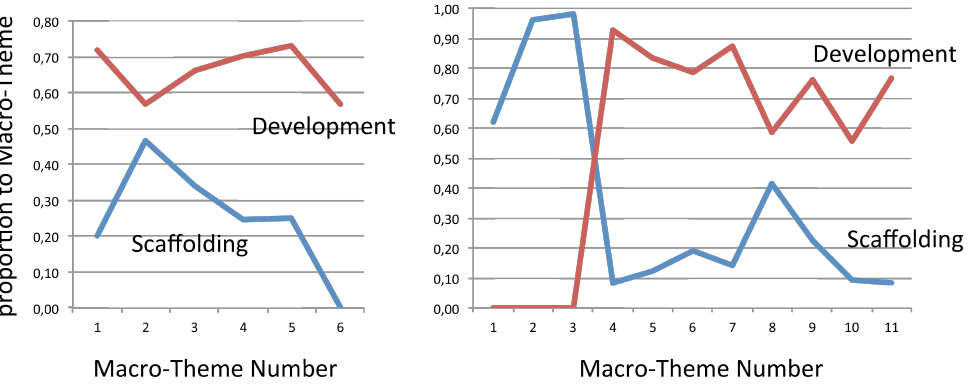
Figure 4. Comparison of discourse construction strategy profiles (proportions with respect to visual macro-themes) across: Video 1 ( left ); and Video 3 ( right